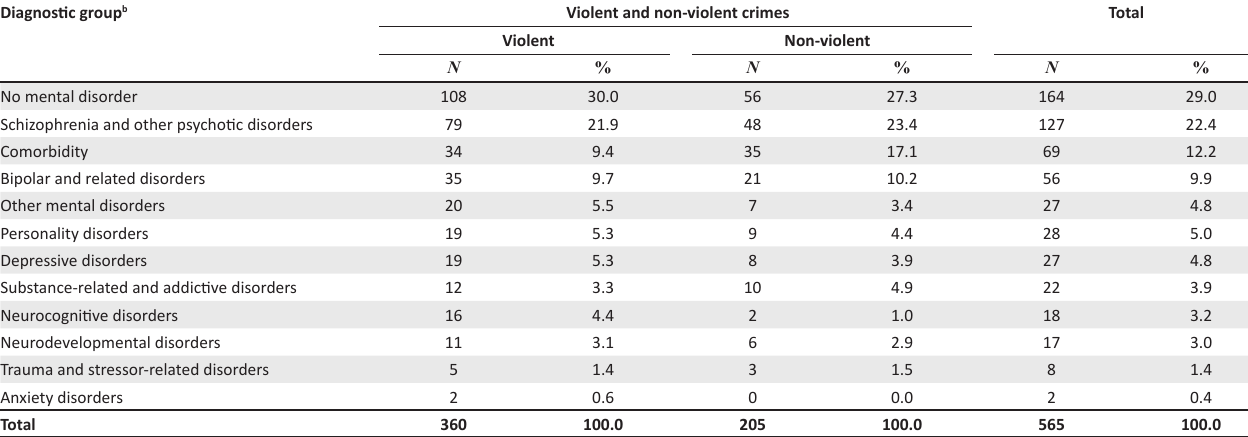
TABLE 5: Diagnostic groups and the nature of offences ( n = 565). a Diagnostic group b